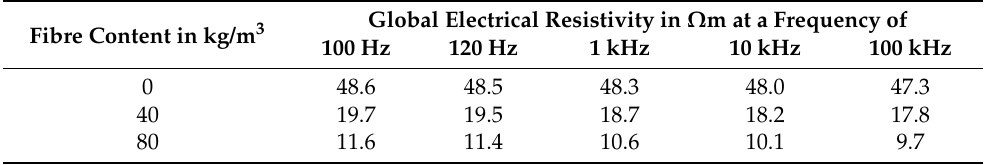
Table A49. Results of the resistivity measurements of the concrete mixture 32-60-300-00 after storage in synthetical pore solution for 28 days for the investigations of possible leaching